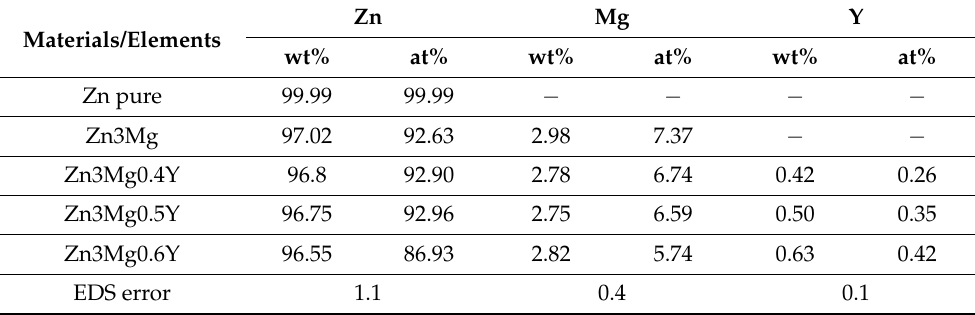
Table 2. Chemical compositions of the samples (average values from five